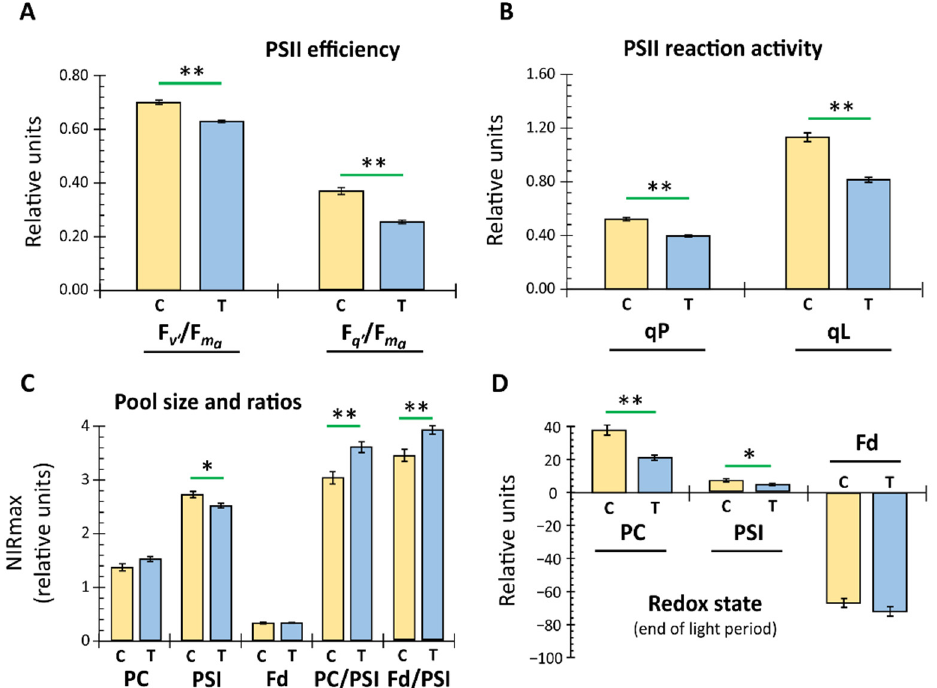
Figure 3. Effect of 48 h electromagnetic field irradiation on photosynthetic parameters in A. thaliana . The control (C) and treatment (T) groups were handled as described (2.2). The recorded data, as given in Figure 2, were further evaluated for identifying specific irradiation effects among differently derived photosynthetic parameters and their statistical significance. Parameters such as maximum PSII efficiency in light (F v’ /F ma ; A ), operating PSII efficiency in light (F q’ /F ma ) ( A ), coefficient of photochemical fluorescence quenching (qP; B ), and estimated fraction of open PSII reaction centers (qL; B ) were calculated (means ± SE, n = 34–37, p < 0.01 **, Student’s t -test). Derivation of these parameters is based on the recorded initial chlorophyll a fluorescence maxima in dark-adapted leaves on exposure to actinic light (160 µmol photons m − 2 s − 1 ). Dual-KLAS-NIR (Walz, Germany) also enables automated estimation of pool sizes and their respective ratios for PC, PSI, and Fd, given as maximum absorption in the near-infrared NIRmax ( C ) (means ± SE, n = 34–37, p < 0.05 *, and < 0.01 **, Student’s t -test). ( D ) The recorded redox state for PC, PSI, and Fd at the end of the light period was compared between control and treated plants, and the significant differences are indicated (means ± SE, n = 34–37, p < 0.05 *, and < 0.01 **, Student’s t -test).